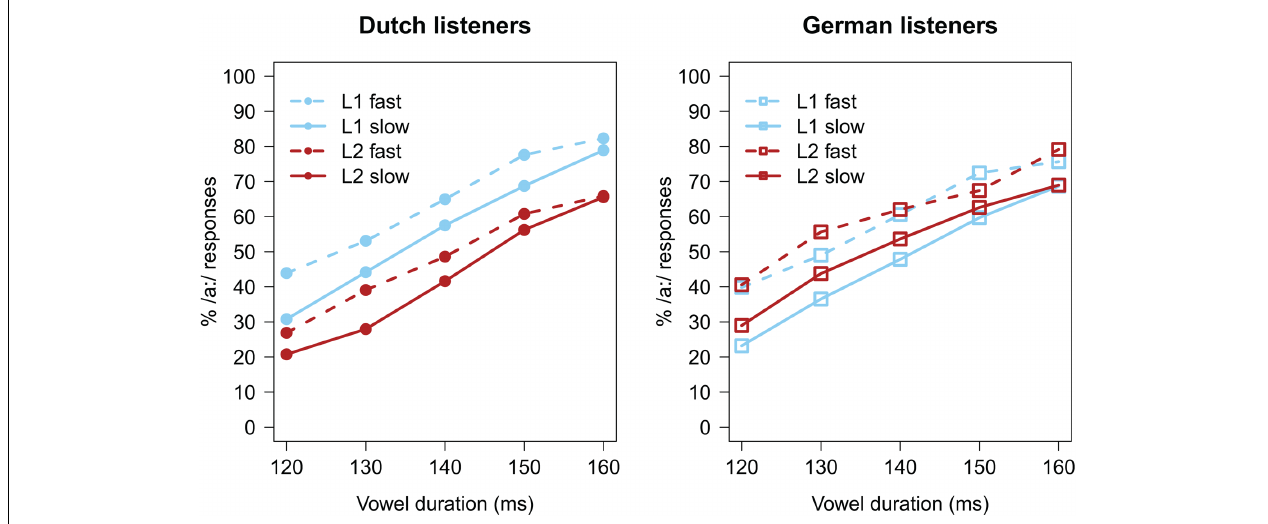
FIGURE 1 | Average categorization data (in % /a:/ responses) of Experiment 1. (Left) Data from the Dutch listener group; (Right) data from the German listener group.